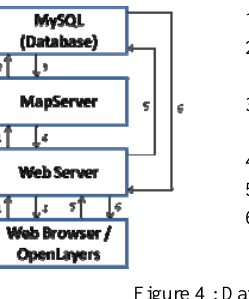
Figure 4 : Data Flow